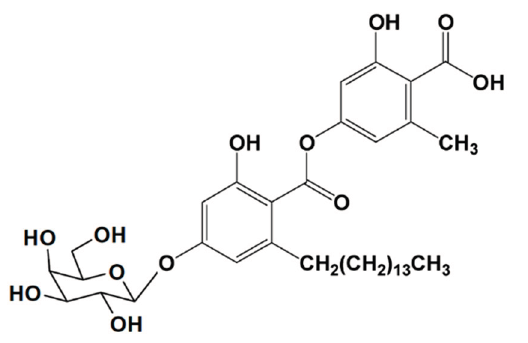
Figure 4. Aquastatin A ( 13 ), isolated from marine-derived fungus Cosmospora sp. SF-5060